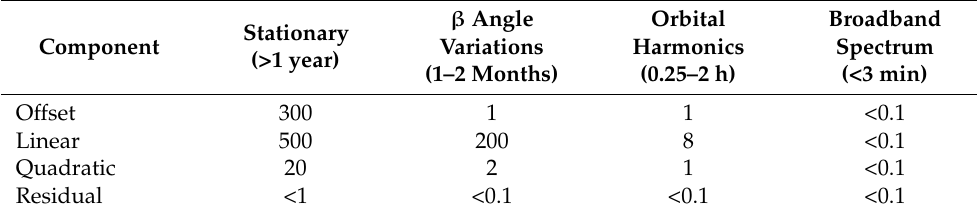
Table 1. Synthesis of the uncalibrated error RMS from STOP21 for different time scales (columns), and for all the components (rows). Unit: